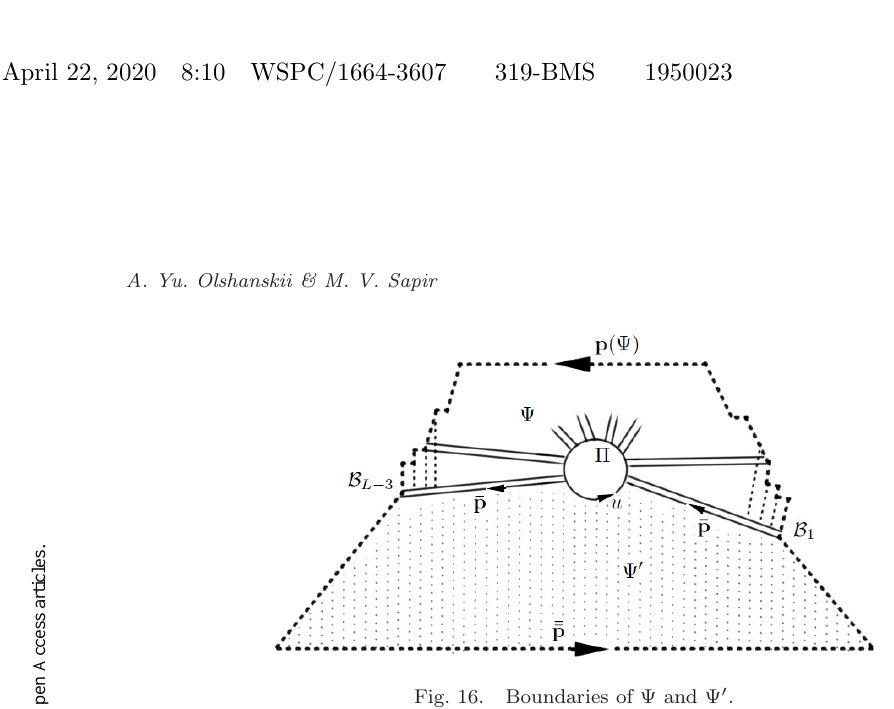
Fig. 16. Boundaries of Ψ and Ψ (cid:2)